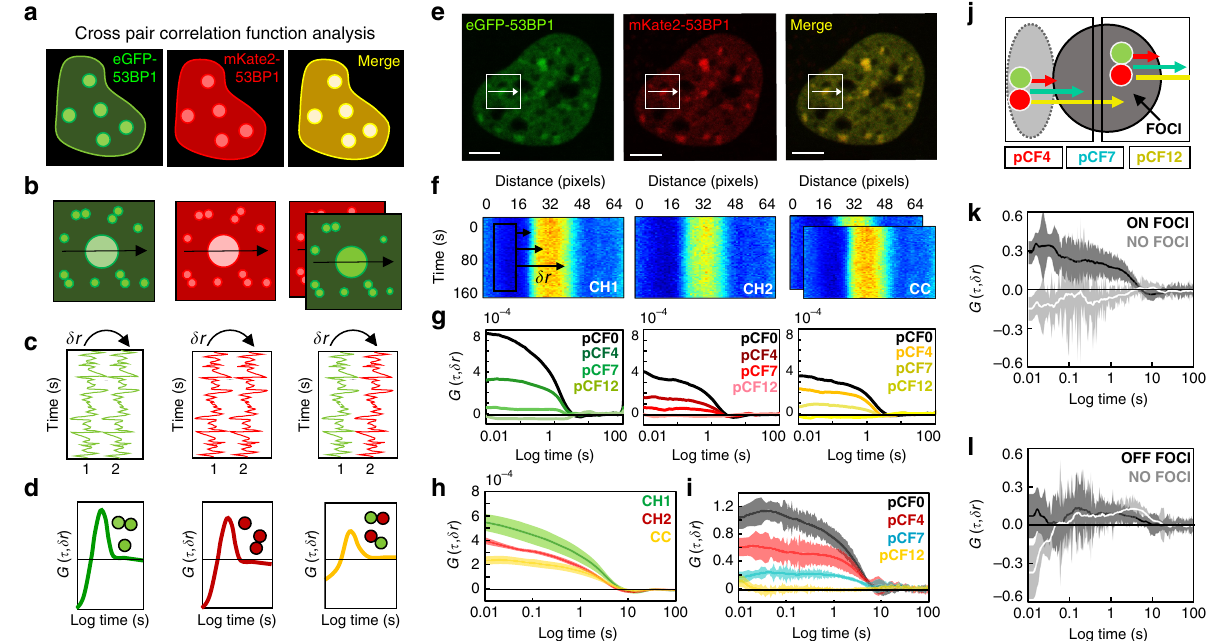
Fig. 3 Cross pCF analysis tracks 53BP1 dimer recruitment and retention at DSBs. a , b . Schematic of how co-labeling 53BP1 with eGFP and mKate2 ( a ) alongside acquisition of a two-channel line scan ( b ) enables 53BP1 dimers to be tracked by cross-pair correlation function (pCF) analysis. c , d Schematic of how the fl uorescence fl uctuations that result ( c ) can be spatially cross-correlated within each channel to track eGFP-53BP1 vs. mKate2-53BP1 transport or spatially cross-correlated between two channels ( d ) to track eGFP-53BP1 molecules in complex with mKate2-53BP1. e Confocal image of a DIvA cell nucleus co-transfected with eGFP-53BP1 and mKate2-53BP1 that has been treated with 4OHT. f Intensity carpet of a two-channel line scan acquired across a 53BP1 foci from the cell selected in e , in the green (CH1), red (CH2), and cross-correlated channels (CC) (schematic of the fi rst 10 pixels cross-correlated at δ r = 0, 4, 7, and 12 pixels (i.e., pCF0, pCF4, pCF7, and pCF12) is superimposed over CH1). g Overlay of the pCF0, pCF4, pCF7, and pCF12 pro fi les derived in the green (CH1) vs. red (CH2) channels of the two-channel line scan presented in f and the corresponding cross-pCF pro fi les (yellow) (pCF0 = 80 nm (pixel diameter), pCF4 = 320 nm, pCF7 = 560 nm, and pCF12 = 980 nm). h Overlay of cross pCF0 analysis of 53BP1 dimer mobility (yellow) with pCF0 analysis of total 53BP1 mobility (green, red) to extract the fraction of 53BP1 dimer present in the nucleoplasm ( N = 5 cells, shading indicates SEM). i Overlay of cross-pCF4, pCF7, and pCF12 analysis of 53BP1 dimer transport from the nucleoplasm onto a DSB foci normalized with respect to pCF0 to compare transit ef fi ciency ( N = 5 cells, shading indicates SEM). j Schematic of the spatial evolution of 53BP1 dimer transport onto vs. off a DSB foci (pCF7 reaches outside the point spread function). k , l Cross-pCF7 analysis of 53BP1 dimer translocation onto a DSB foci ( k ) vs. off this structure ( l ) that is normalized with respect to cross pCF0 ( N = 5 cells, shading indicates SEM). Scale bars, 5 μ analysis to be effective at tracking 53BP1 dimer diffusion with onto a DSB foci and compared this transit with 53BP1 dimer respect to a DSB foci, however, we must fi rst optimize the dis- transport off this structure (Fig. 3k, l and Supplementary tance ( δ r ) at which we spatially cross correlate the two different Fig. 5d – i). This analysis revealed that (1) the presence of a DSB colored 53BP1 fl uorescence fl uctuations. Thus, in co-transfected regulates the recruitment of 53BP1 dimer onto a DSB, as in the DIvA cells treated with 4OHT for 60 min (Fig. 3e) we (1) absence of a DSB, no 53BP1 dimer translocation is detected acquired two-channel line scan data across DSB foci (Fig. 3f) and (Fig. 3k) and, (2) although signi fi cant 53BP1 dimer translocation is detected onto a DSB, no 53BP1 translocation is detected off this (2) performed pCF (green and red pro fi les) vs. cross-pCF analysis structure (Fig. 3l). Thus, collectively these results suggest that (yellow pro fi le) of 53BP1 mobility within each pixel ( δ r = 0), as 53BP1 dimers are recruited to DSBs and upon arrival accumulate well as over three different spatial scales ( δ r = 4, 7, and 12 pixels) at this location, because 53BP1 dimers do not translocate off (Fig. 3g) to establish the fraction of 53BP1 dimer present and the a DSB. condition in which we track this population onto a DSB foci. From pCF analysis of eGFP-53BP1 and mKate2-53BP1 local mobility (monomers and dimers) in the nucleoplasm at δ r = 0 The DNA DSB histone code differentially regulates the spa- (pCF0), and comparison of this analysis with the cross pCF0 tiotemporal distribution of 53BP1 oligomerization during the pro fi le of 53BP1 dimers only, we fi nd the fraction of 53BP1 dimer DDR . NB (Fig. 2) and cross-pCF analysis (Fig. 3) have so far shown present to be 31 ± 4% (Fig. 3h) after correction for spectral bleed that preformed 53BP1 dimers are recruited to DSBs, and upon through (Supplementary Fig. 5a – c). From cross-pCF analysis of arrival, they immobilize as well as self-associate into higher-order this 53BP1 dimer fraction ’ s transport onto a DSB foci at a oligomers. Next, to dissect the role of the DSB histone code that distance of δ r = 4, 7, and 12 pixels (pCF4 = 320 nm, pCF7 = 53BP1 binds, in regulation of 53BP1 self-association during this 560 nm, and pCF12 = 980 nm), we fi nd the spatial evolution of recruitment mechanism, we performed NB FFS measurements on (30 – 50% ef fi ciency) and not beyond this distance range at cross pCF12 (0% ef fi ciency) (Fig. 3i). Given that the dimensions of our line scan results in cross-pCF4 favoring local mobility (Fig. 3j), we proceeded with cross-pCF7 that favours 53BP1 dimer transport